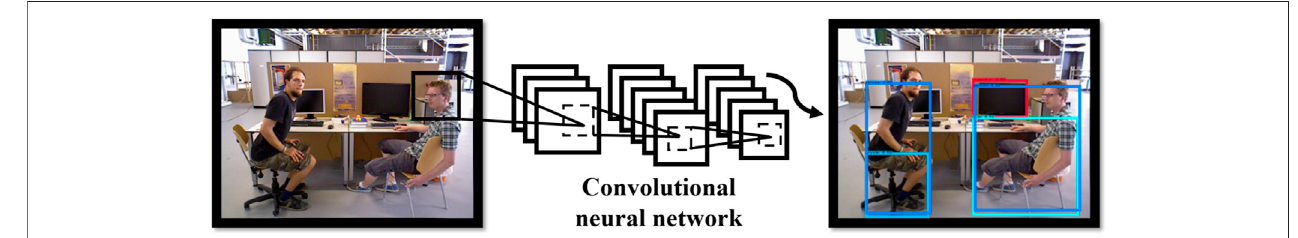
FIGURE 3 | The demonstration of YOLO-Fastest algorithm object detection for TUM dataset.